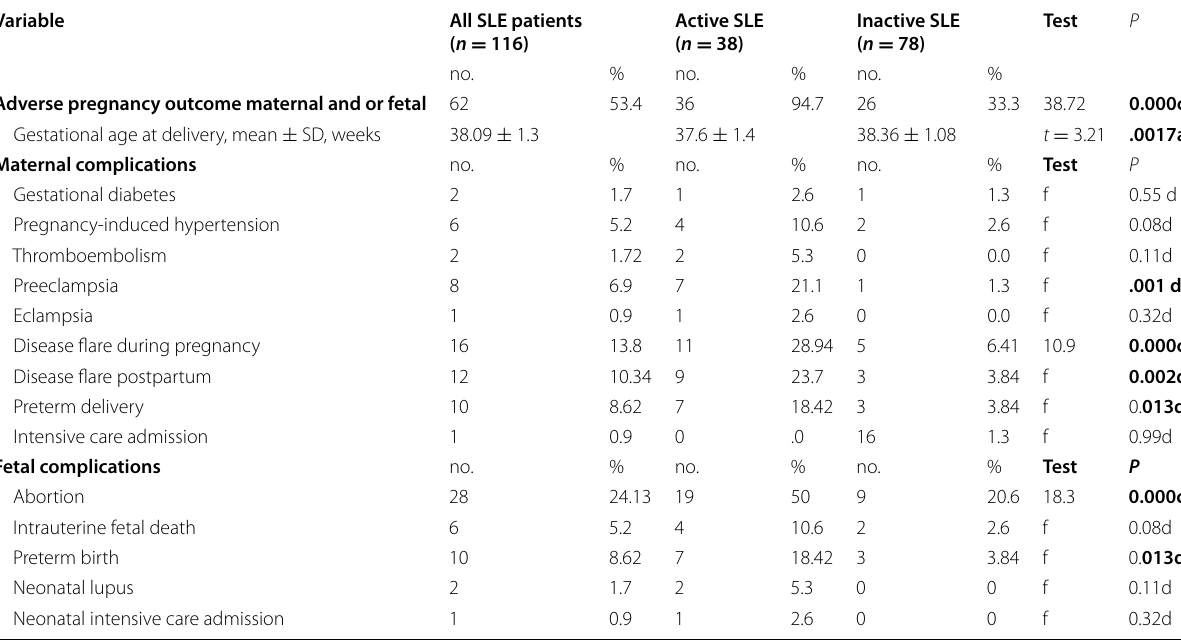
SLE systemic lupus erythematosus. All values are presented as mean SD or median (range) or number (%). a Independent t -test, c chi-square test, d Fisher test. ± Insignificant, P > 0.05; significant, * P 0.05 ≤ Table 4 Univariate analysis for predicting adverse pregnancy outcomes in lupus patients